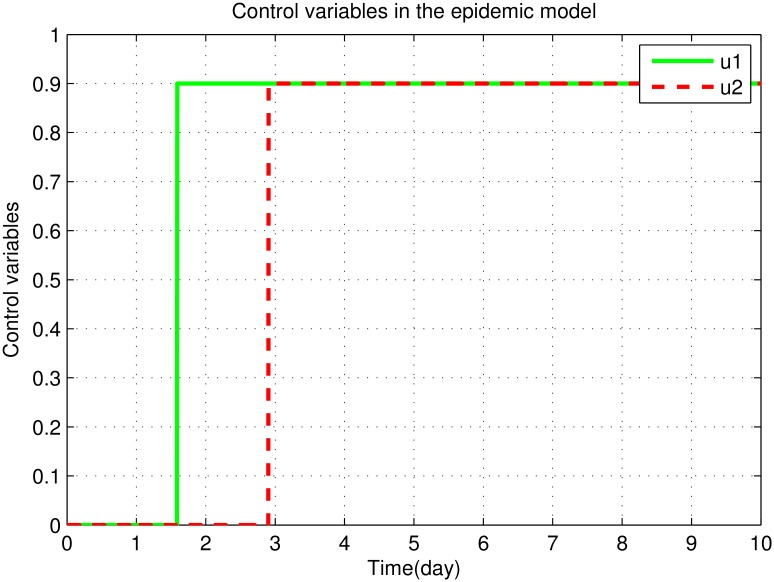
The graph shows the control variables u1 and u2.